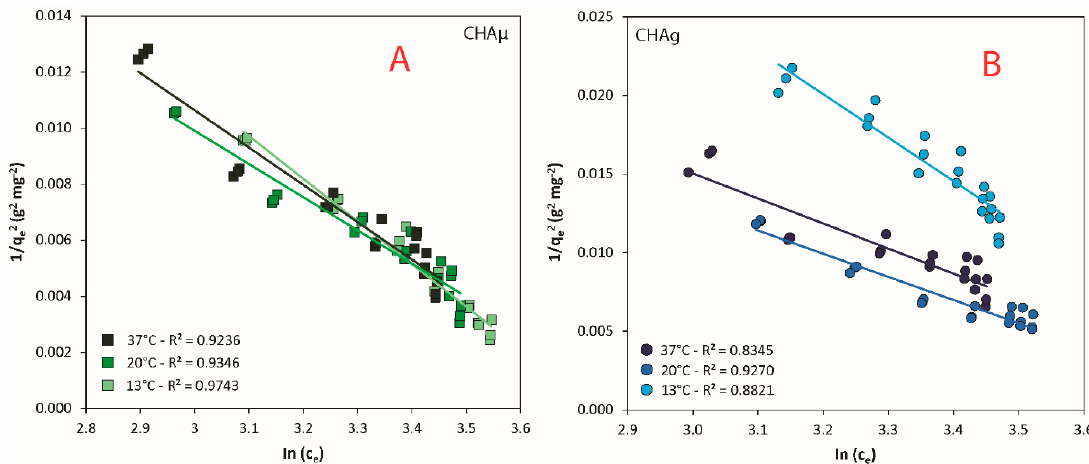
Figure 2. ln( C e ) against 1 / q e2 (Linear Harkins-Jura isotherms; Equation (2)) for CHA µ and CHAg at temperatures T = 13, 20, and 37 ◦ C: ( A ) Isotherms for CHA µ at the temperature investigated and with the respective R 2 values; ( B ) Isotherms for CHAg at the temperature investigated and with the respective R 2 values.